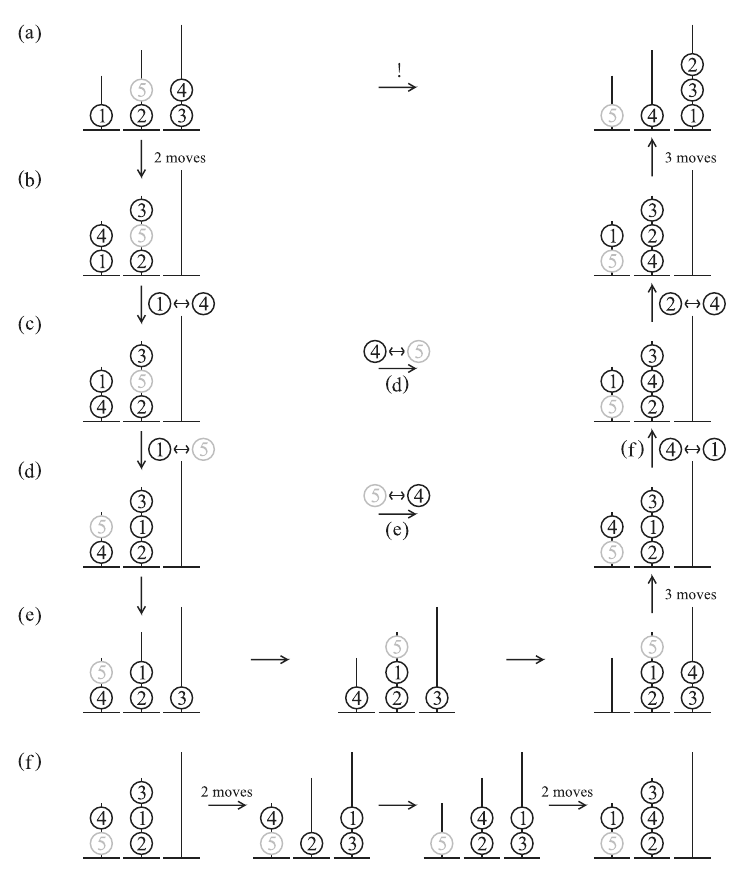
Fig. 5. Example for an application of the algorithm in the proof of the